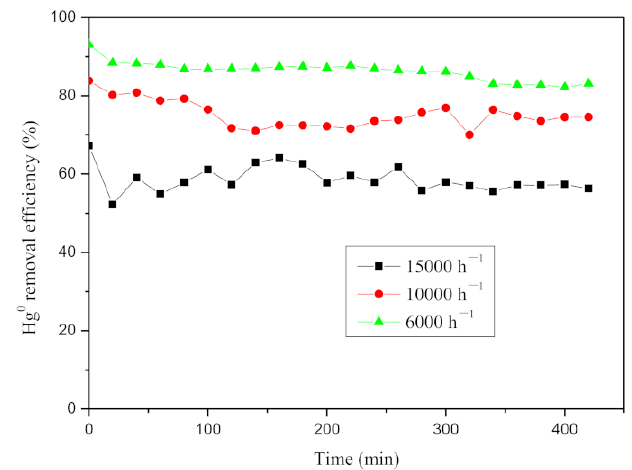
Figure 5. Effect of GHSV on Hg 0 removal over 5V 2 O 5 /PG (reaction conditions: O 2 = 8%, H 2 O = 5%, SO 2 = 0.15%, N 2 as balance, C Hg 0 = 240 µ g/m 3 , GHSV = 6000–15,000 h − 1 , T = 150 ◦